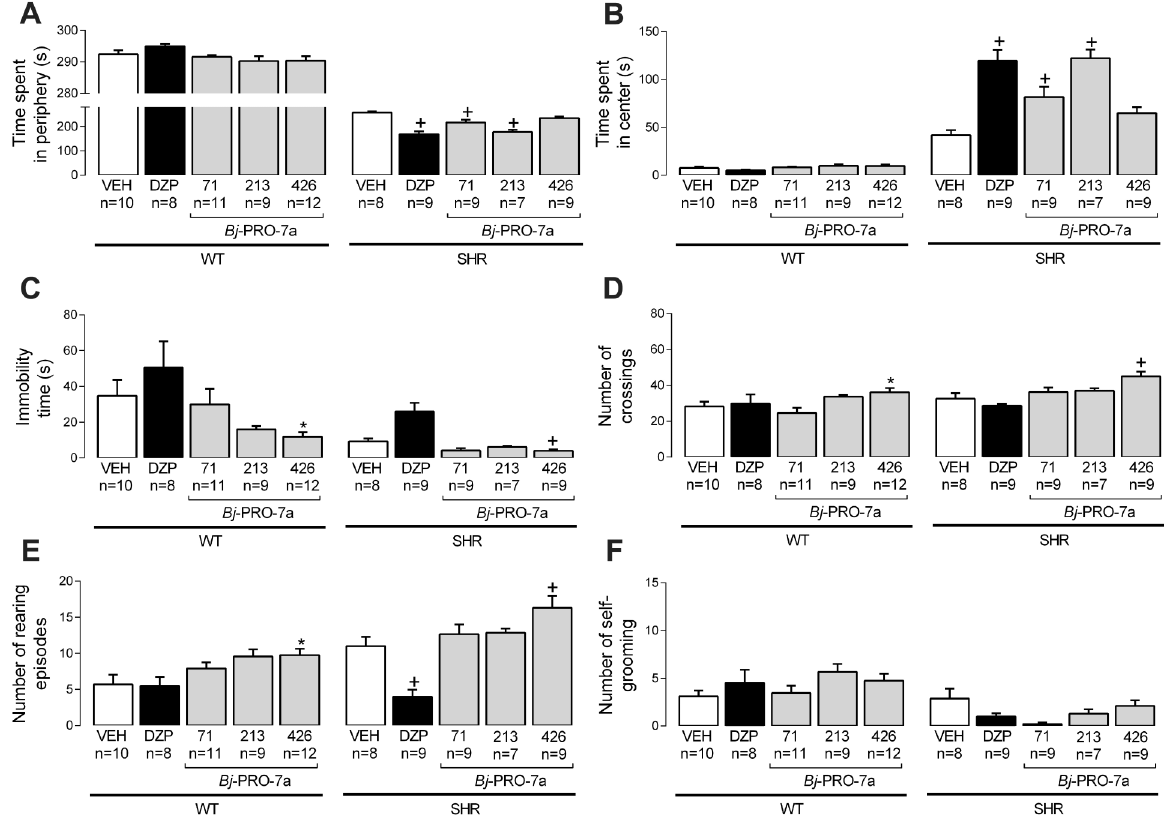
Figure 2. Effects of Bj-PRO-7a on locomotion and exploration activities in the open fi eld in Wistar (WT) and spontaneously hypertensive rats (SHRs). A , Time spent in periphery; B , Time spent in center; C , Immobility time; D , Number of crossings; E , Number of rearing episodes; F , Number of self-grooming episodes. Experimental groups: VEH: vehicle (0.9% NaCl); DZP: diazepam (2 mg/kg); Bj-PRO-7a (71, 213, or 426 nmol/kg). Data are reported as means ± SE. *P o 0.05 vs VEH WT; + P o 0.05 vs VEH SHR (two-way analysis of variance followed by Bonferroni ’ s post hoc